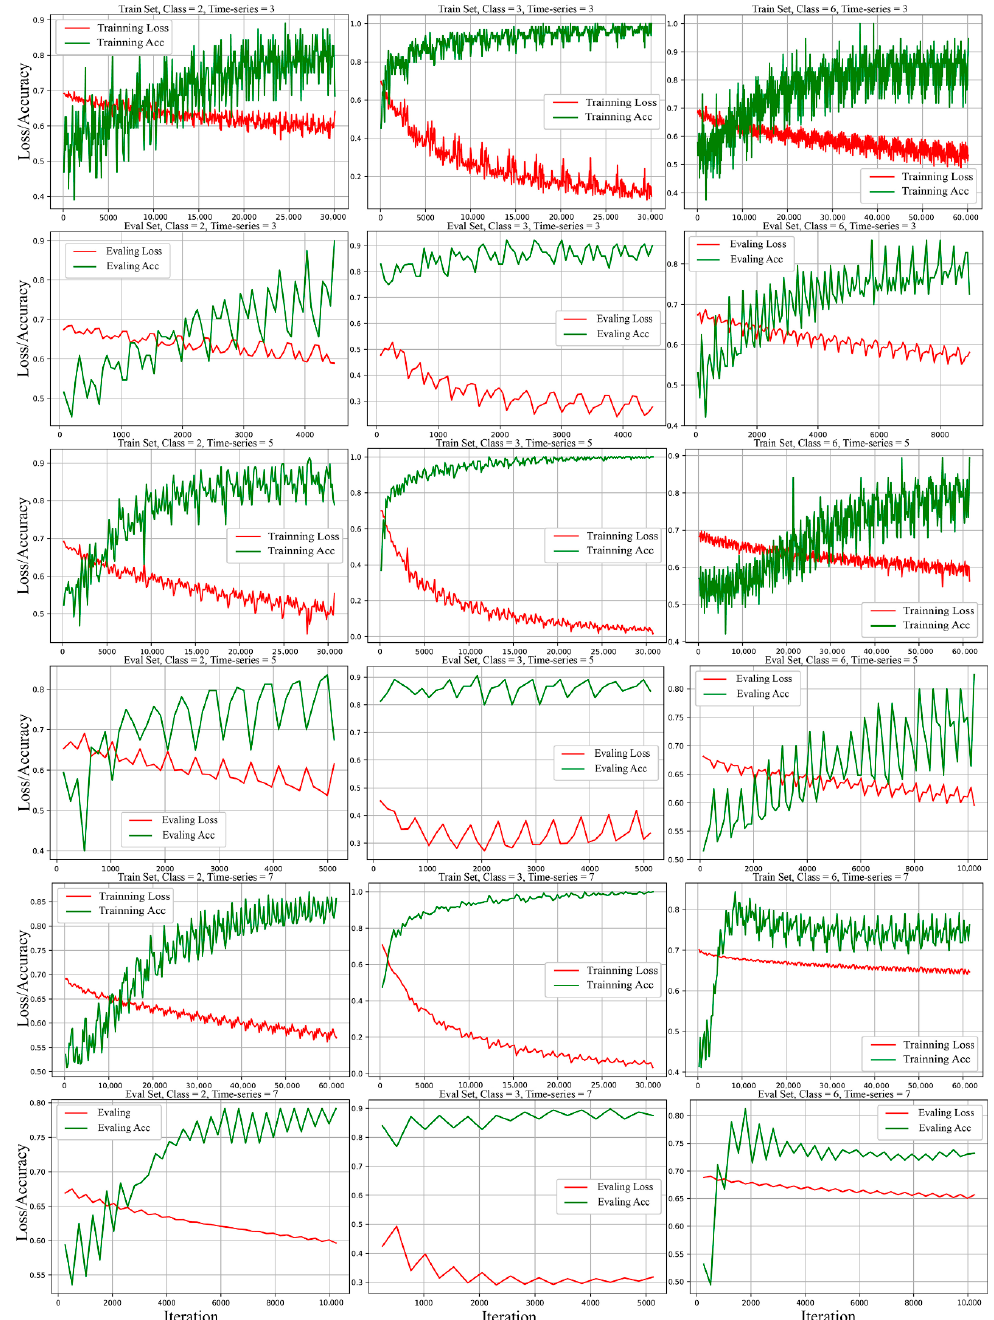
Figure 8. Loss and accuracy of the SF-LSTM model training set and validation set under different classification strategies and time series